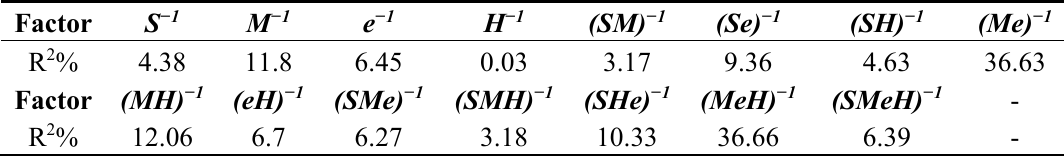
Table 3. Correlation analysis results of the correlation between the mechanical properties and specific wear rate (SWR) of the materials.